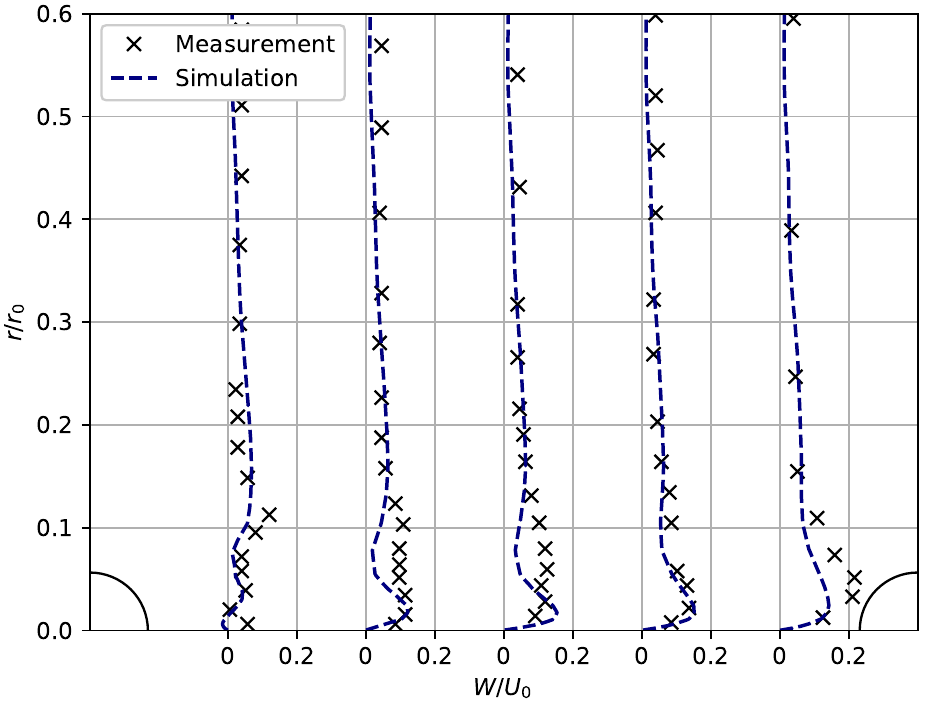
Figure 5. Comparison between measurement and simulation with the velocity in the flow direction.